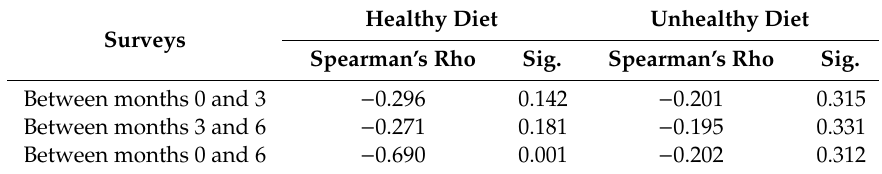
Table 3. Correlation between consuming a healthy / unhealthy diet and the change in body fat